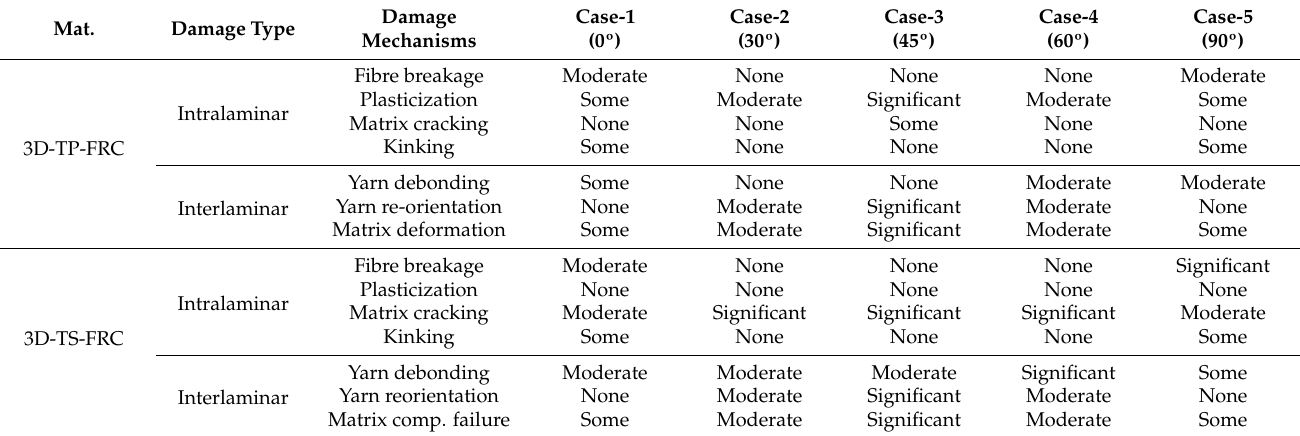
Table 3. The relative severity of damage mechanisms for changing fibre